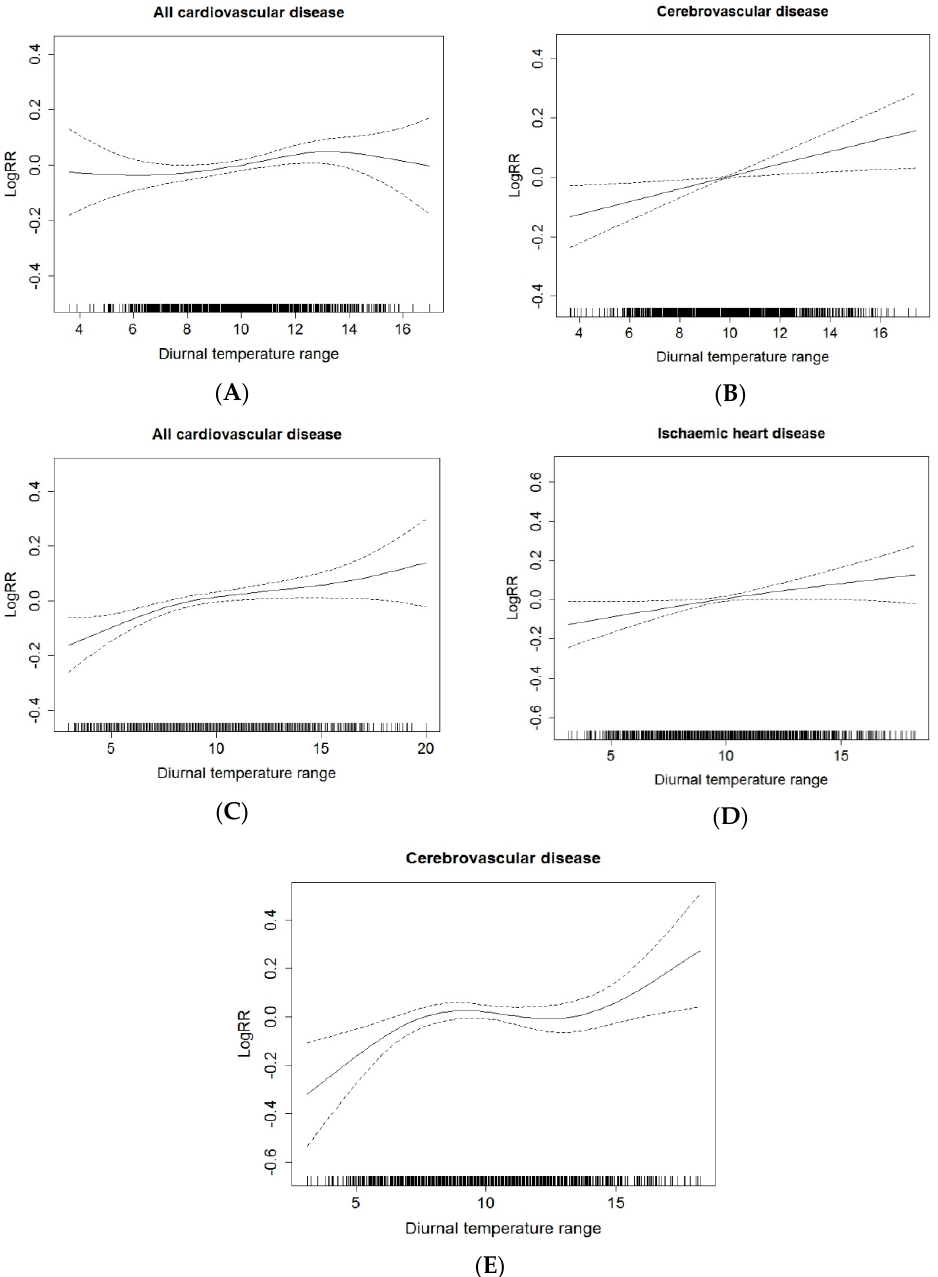
Figure 1. Smoothing plots of DTR against the elderly ER admissions risk of cause-specific cardiovascular disease. X-axis is DTR (°C). The solid lines indicate the estimated mean percentage of change in daily ER admission, and the dotted lines represent twice the standard error. ( A , B ) The relationship between DTR and all cardiovascular disease (L04 day), cerebrovascular disease (L04 day) ER admissions among males; ( C – E ) The relationship between DTR and all cardiovascular disease (L01 day), ischemic heart disease (L02 day) and cerebrovascular disease (L02 day) ER admissions among females. Models controlled for time trend, DOW, holiday, mean temperature, humidity, wind, atmospheric pressure and air pollutant concentrations.